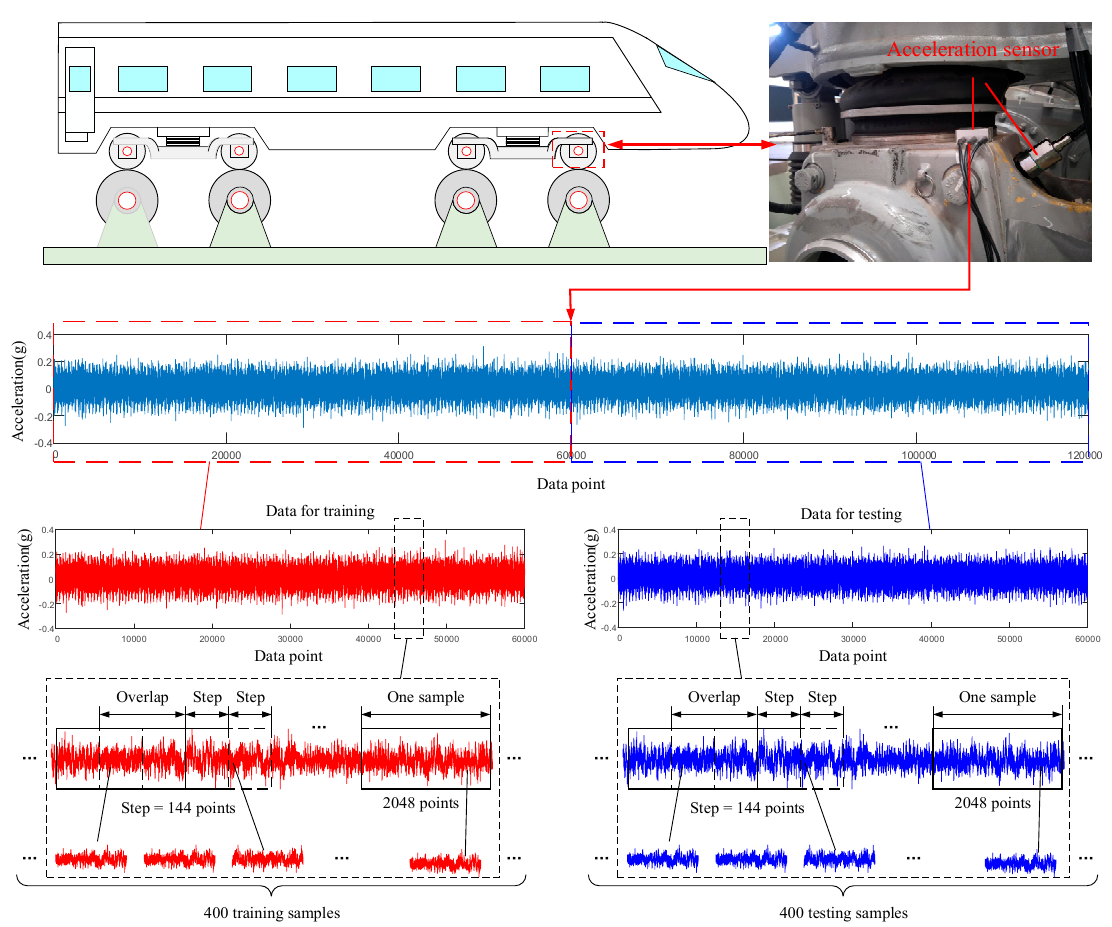
Figure 5. The procedure of generating training and testing samples.